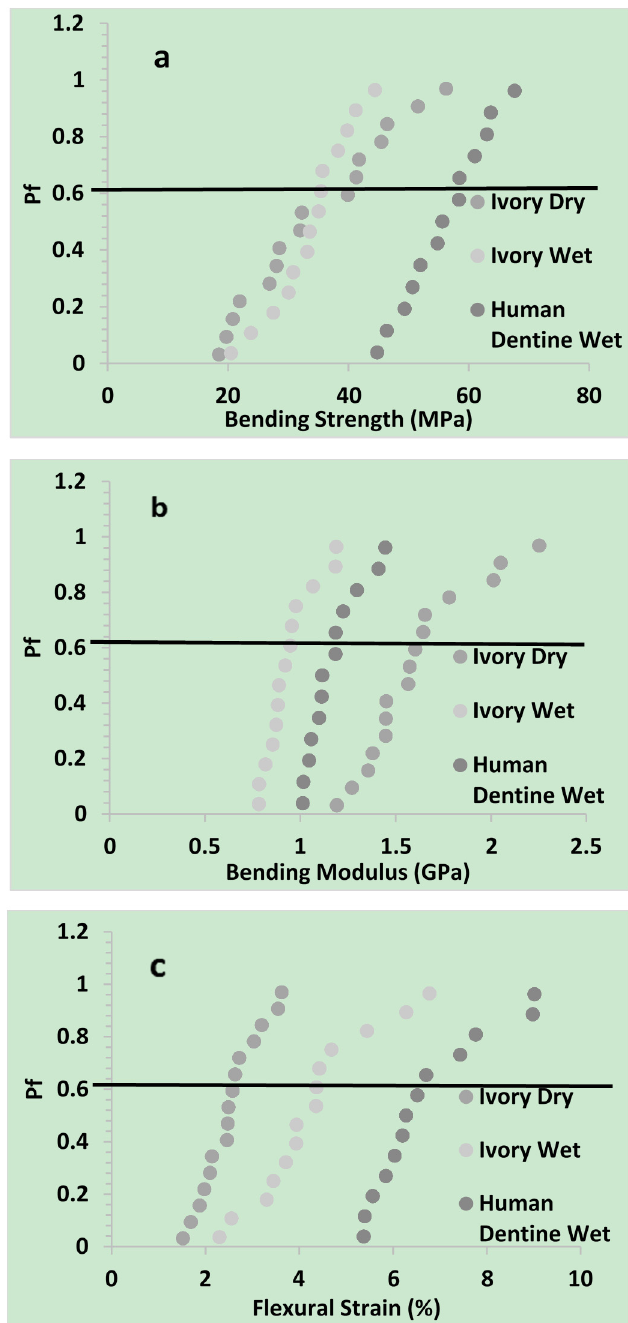
Figure 3. P f was plotted against ( a ) three point bend strength; ( b ) modulus; and ( c ) flexural strain of ivory (dry & wet) and human dentine